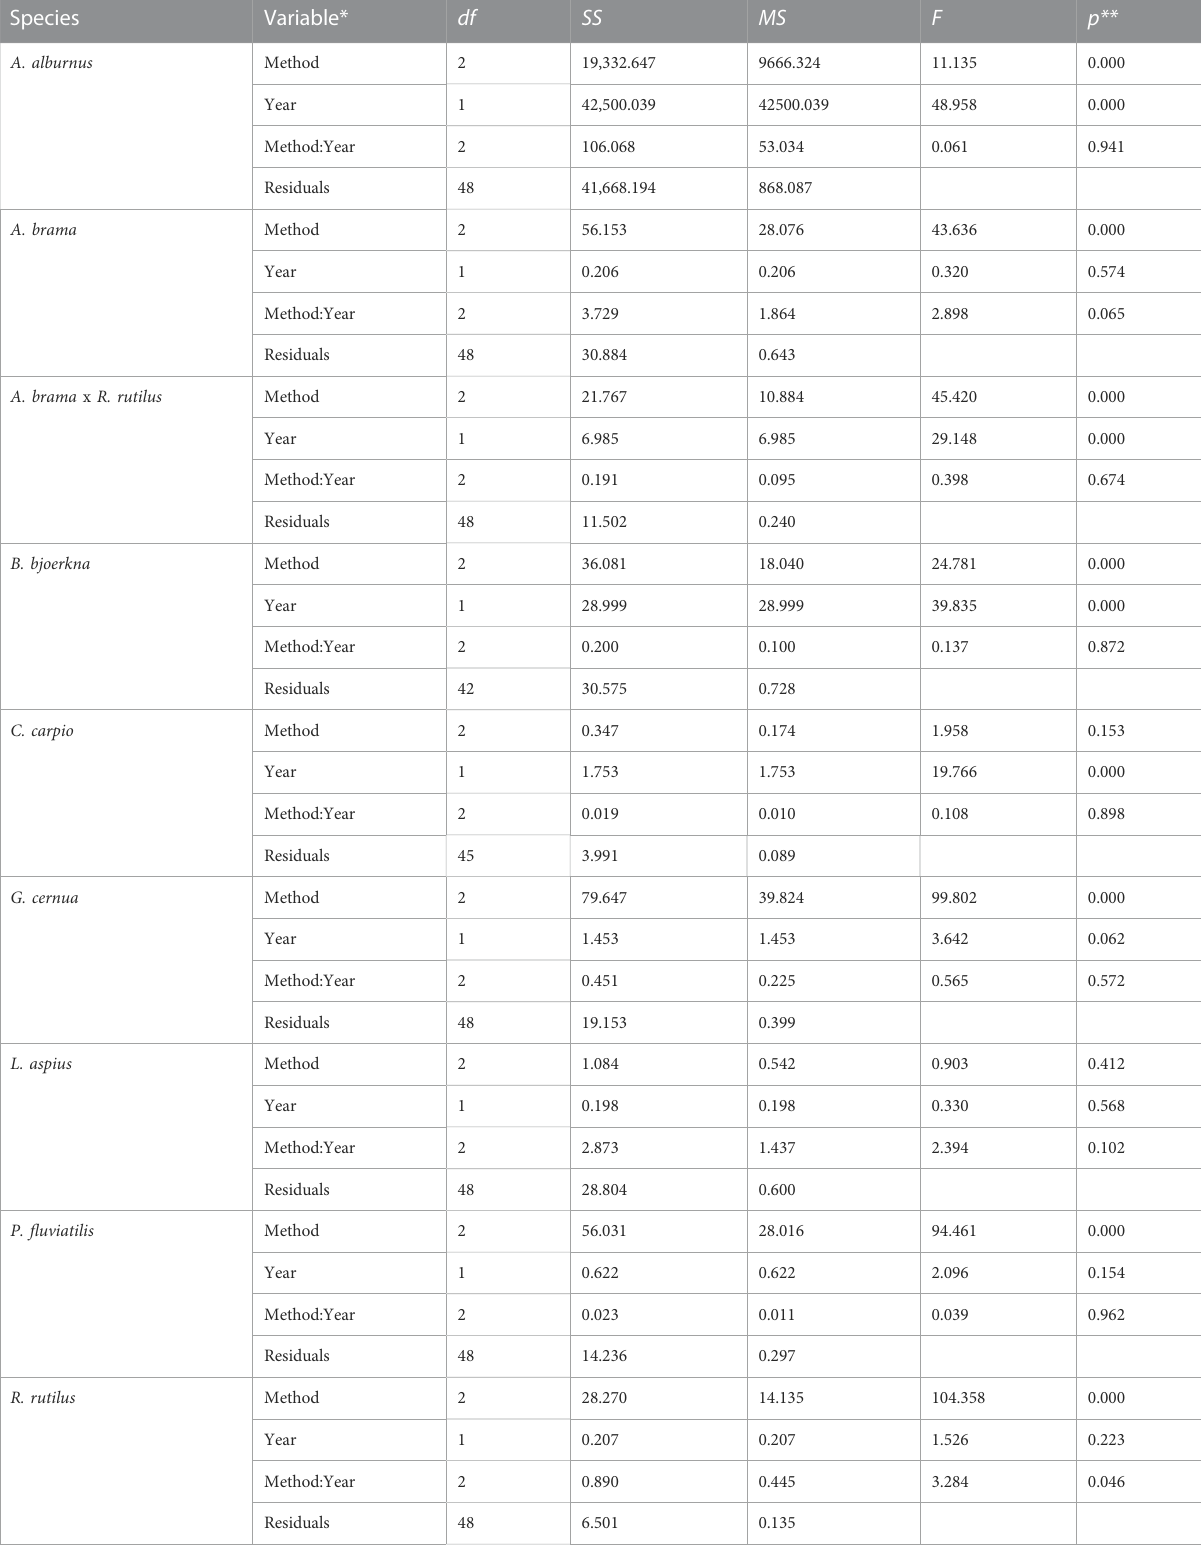
TABLE 4 ANCOVA results of the interaction test for CPUEs of the dominant species and the whole community sampled from 2004 to 2021 in Ř ímov Reservoir, Czech Republic.